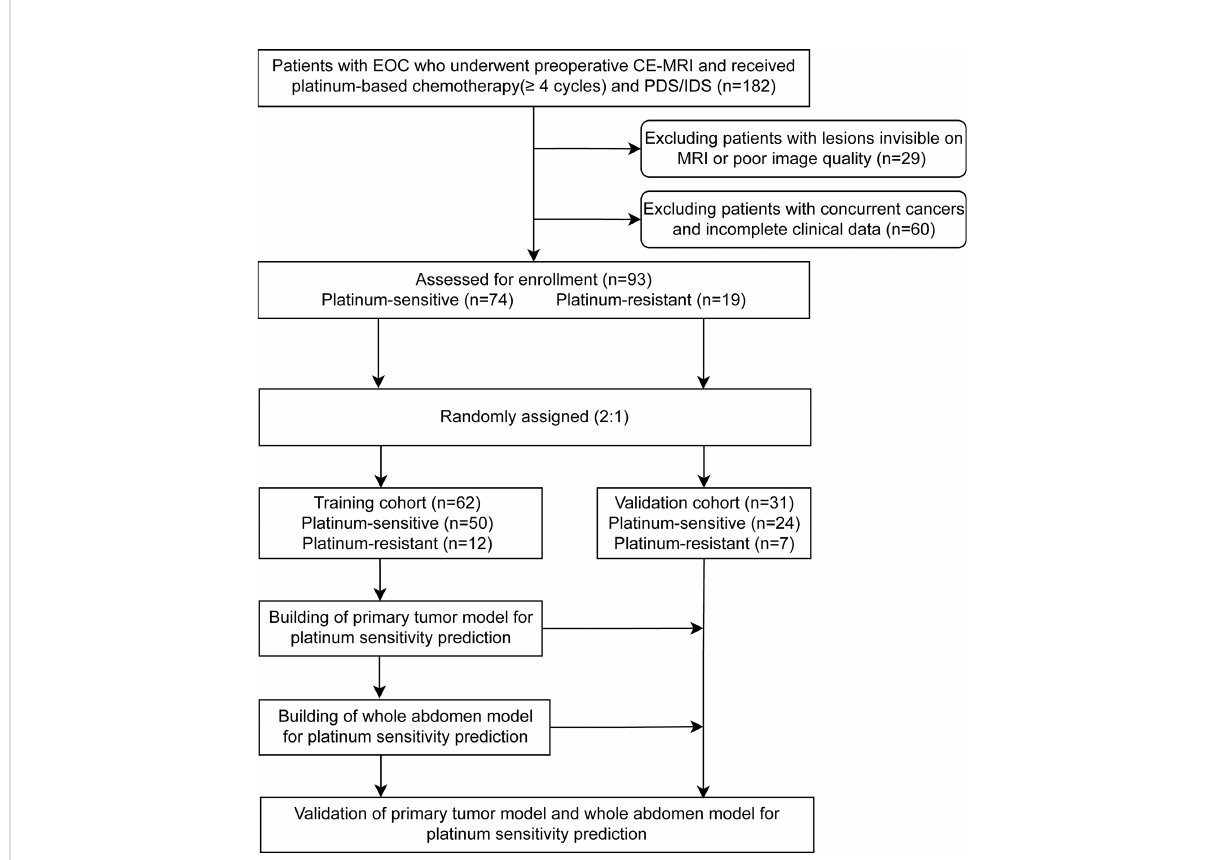
FIGURE 1 Patients ’ recruitment and study design. A total of 93 patients with preoperative magnetic resonance imaging from the Sun Yat-sen Memorial Hospital were enrolled. The two representative deep learning models (whole abdomen model and primary tumor model) were constructed and validated with the same training and validation cohorts, then compared for performance. EOC, epithelial ovarian cancer; CE-MRI, contrast- enhanced magnetic resonance imaging; IDS, interval debulking surgery; PDS, primary debulking